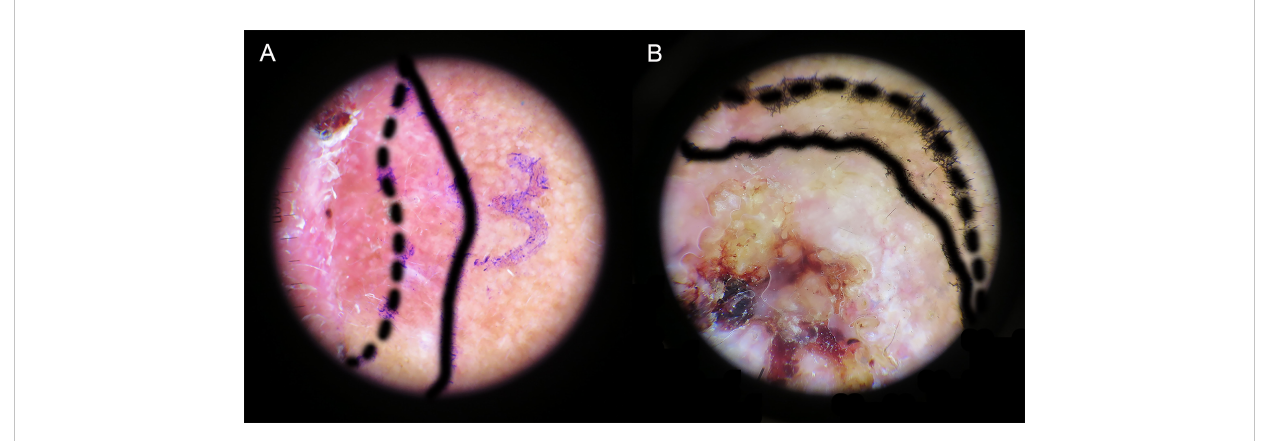
FIGURE 4 Delineation of tumor boundaries by naked-eye (dashed line) and dermoscopy (solid line). (A) Wider dermoscopic edge. (B) Narrower dermoscopic